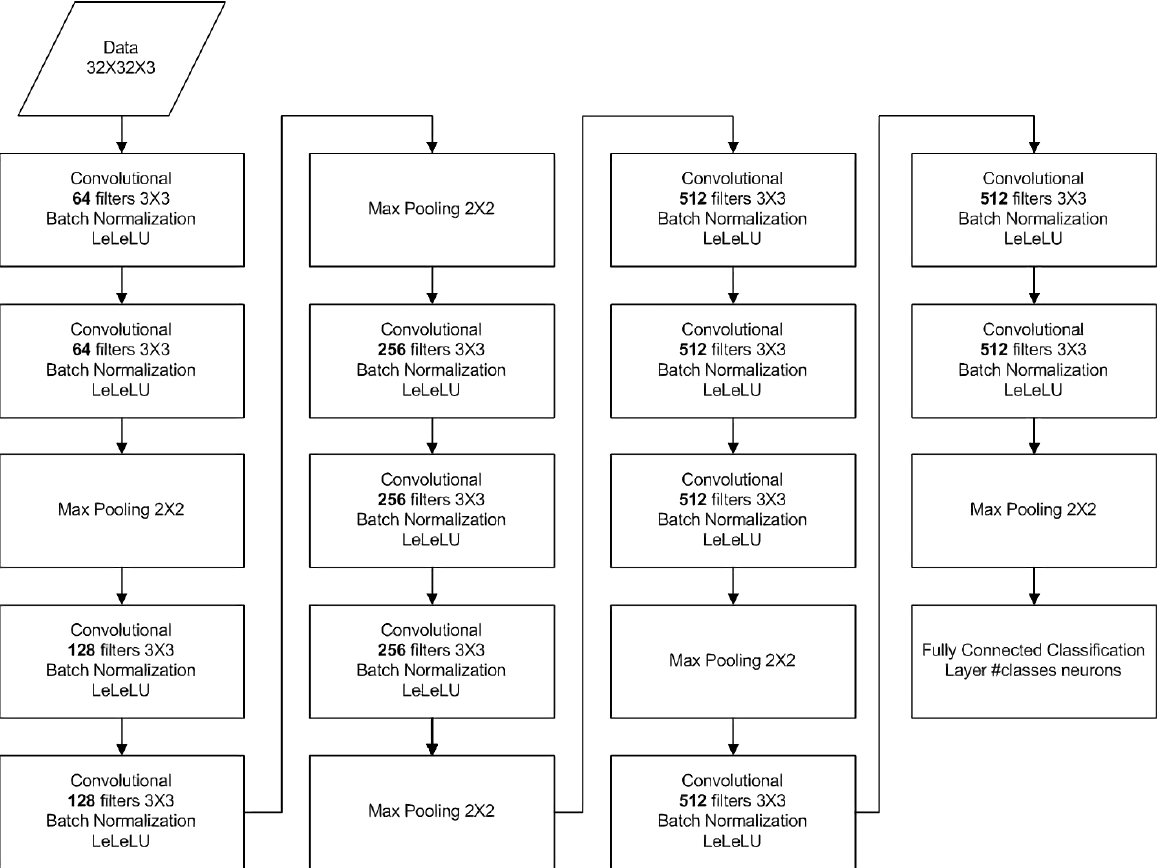
Figure 4. Neural networks VGG-16 topology that was employed for Cifar-10 and Cifar-100. Table 5. Test accuracy in the CIFAR-10 dataset of the activation functions in question, using the VGG-16 neural network, and accuracy normalized to that attained by ReLU activation function.